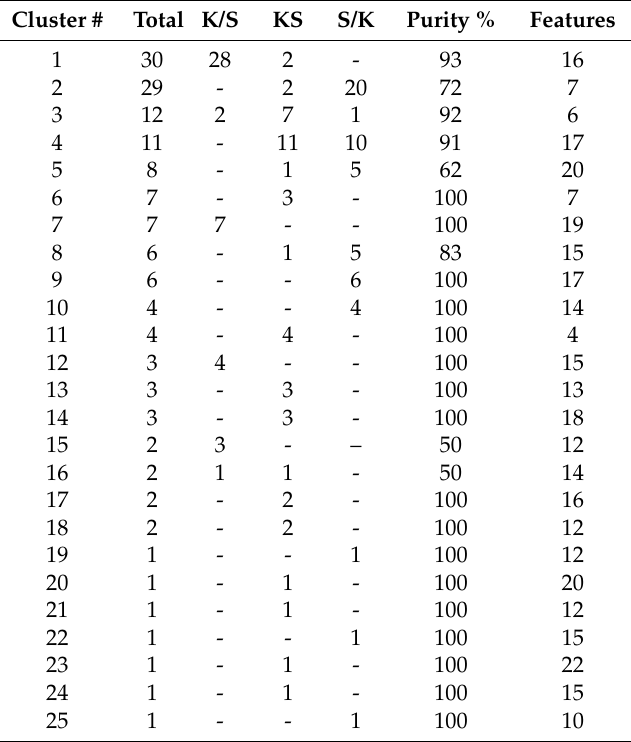
Table 5. Analysis of combined fingerprint